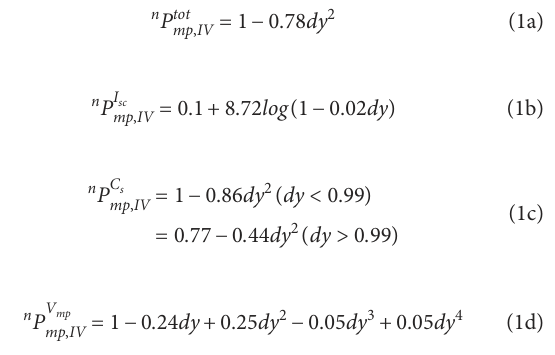
the netSEM package, any pathway with R 2 have a best